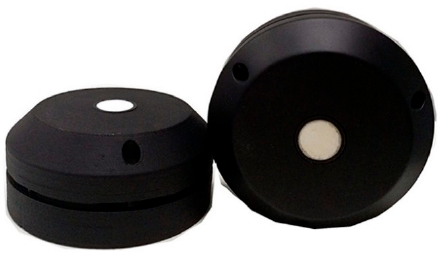
Figure 5. Dingtek DF702.